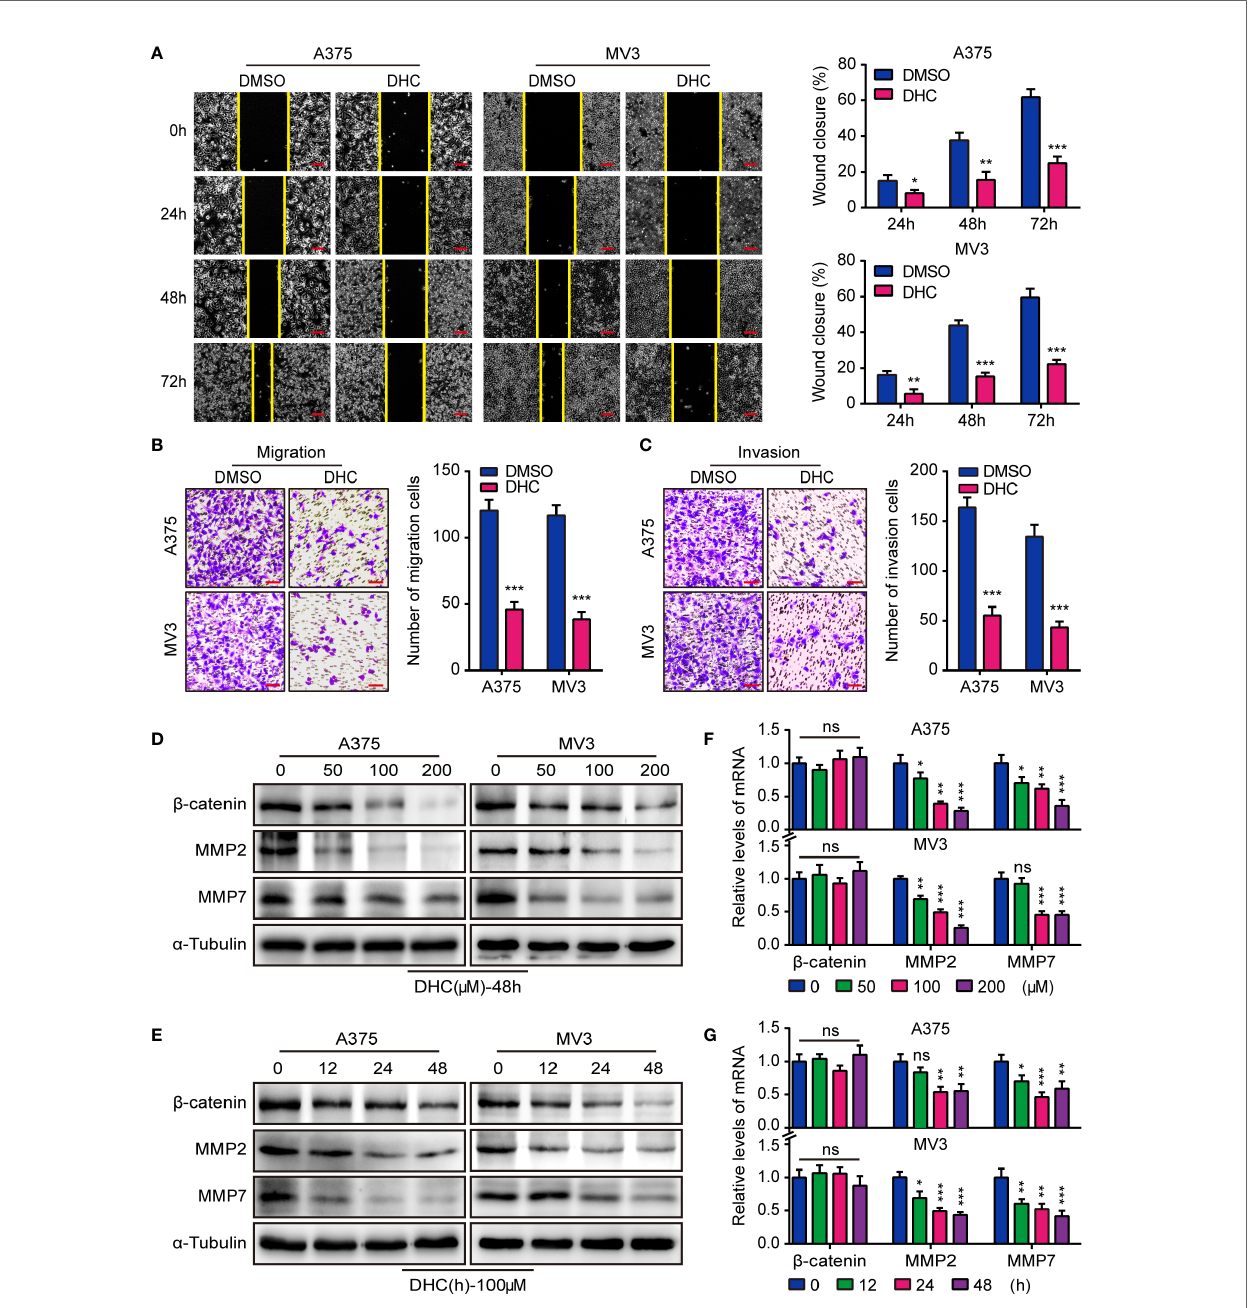
FIGURE 2 | DHC inhibits the migration and invasion of melanoma cells. (A) Wound closure proportion of A375 and MV3 cells under the treatment of 100 m M DHC. Scale bar, 100 m m. (B, C) Migration and invasion transwell assays were performed in A375 and MV3 cells treated with 100 m M DHC. Scale bar, 100 m m. (D, F) The protein and mRNA levels of b -catenin, MMP2, and MMP7 in A375 and MV3 cells treated with 0, 50, 100, and 200 m M DHC for 48 h. (E, G) The protein and mRNA levels of b -catenin, MMP2, and MMP7 in A375 and MV3 cells treated with 100 m M DHC for 0, 12, 24, and 48 h. * P <0.05; ** P <0.01; *** P < 0.001; ns, not signi fi